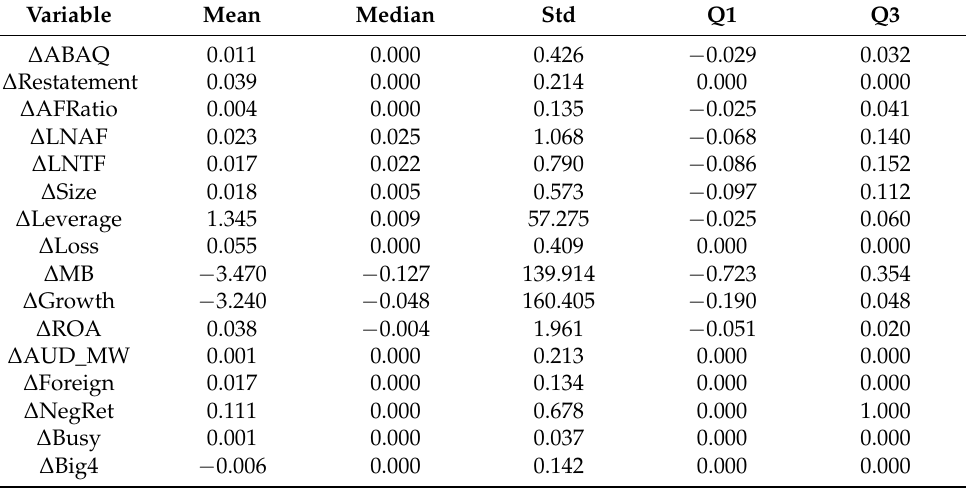
Panel C: Descriptive Statistics for the ABAQ, Restatement, and AF of U.S. sample firms in 1-year pre-Rule 3211 period, after 1st-differencing